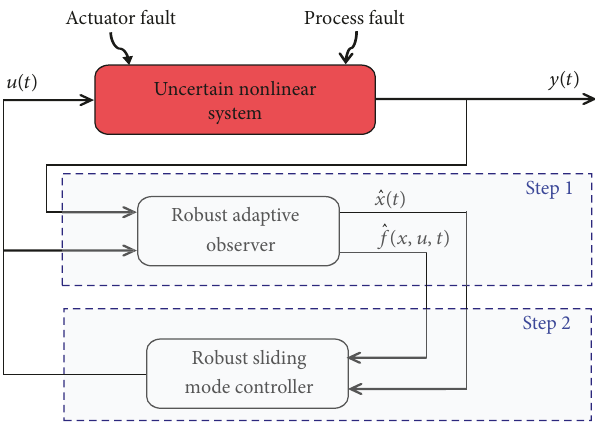
Figure 1: FE-based fault-tolerant control: a separated